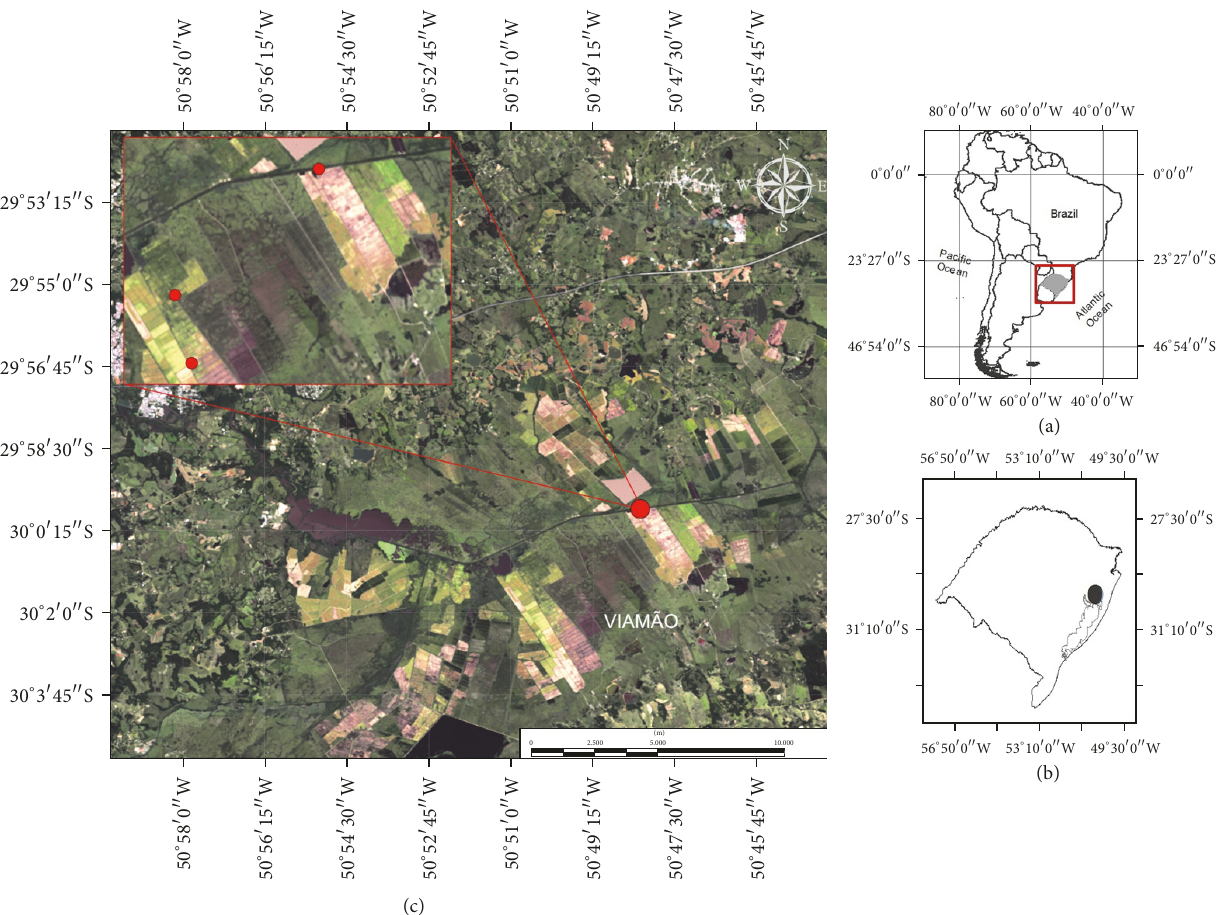
Figure 1: (a) Location of Rio Grande do Sul state, Southern of Brazil. (b) Viam˜ao city, outer coastal plain of Rio Grande do Sul state; (c) study area with the three sampling sites in the flooded rice